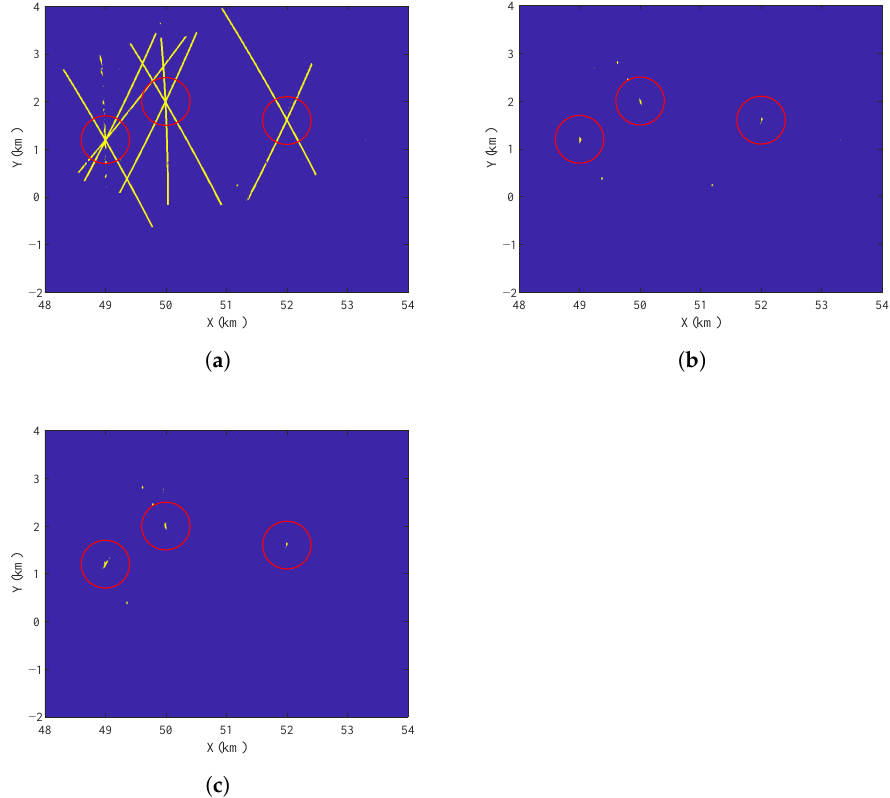
Figure 11. Detection result with three targets when SNR = 2dB. ( a ) The original GLRT detector. ( b ) ID-based detector. ( c ) IC-based